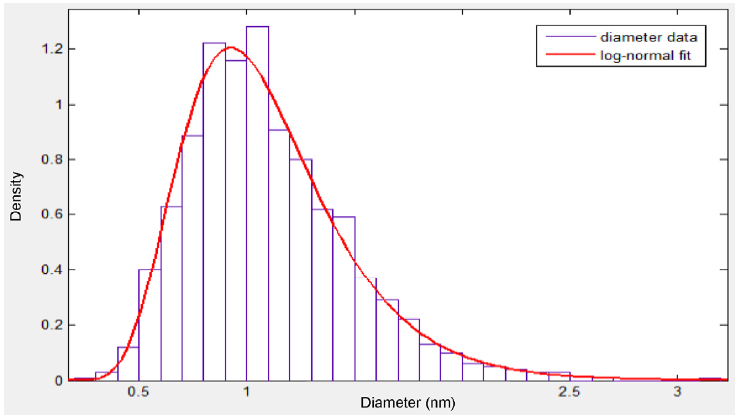
Figure 5. Log-normal distribution of the nanotube diameters.